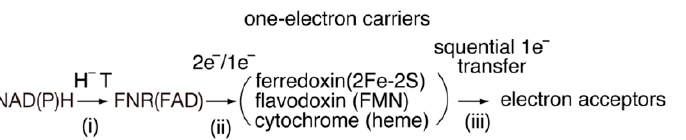
Figure 3. Proposed catalytic cycle of the eukaryotic-membrane-bound cyt P450 reductase-cyt P450 system. In this figure, the overall reaction is based on the catalytic cycle. Note that cyt P450R indicates cyt P450 reductase. H − T, hydride transfer; 1e − T, one-electron transfer; PC1e − T, proton-coupled one-electron transfer.